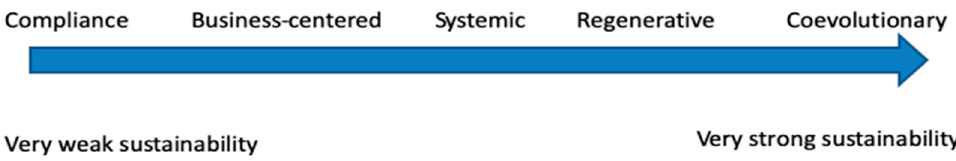
Figure 1. Corporate Sustainability Spectrum. Adapted from Landrum and Ohsowski (2018).